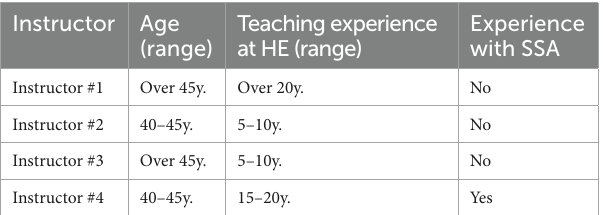
TABLE 1 Demographic description of